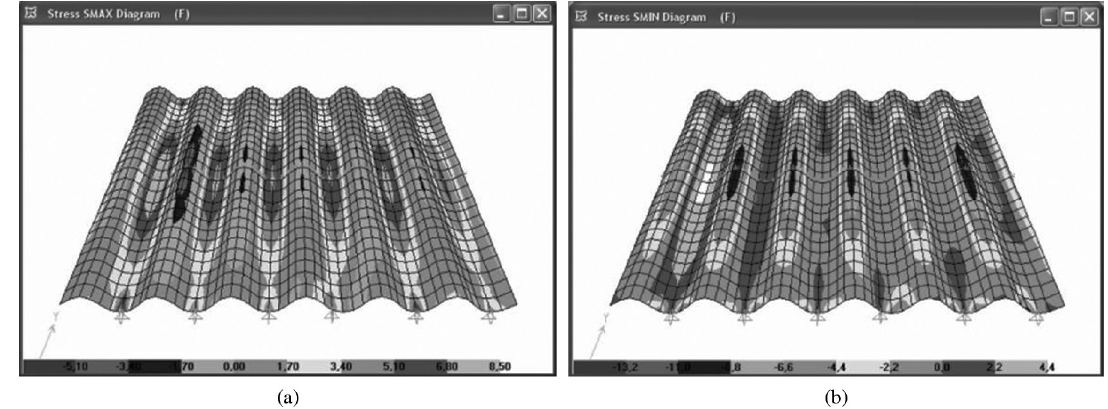
) in the lower surface of the low wave, (b) max